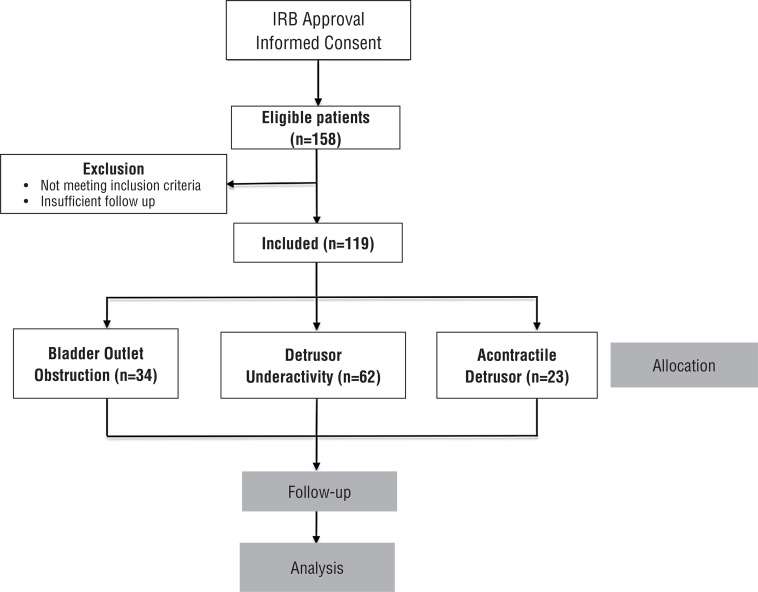
Patient selection.